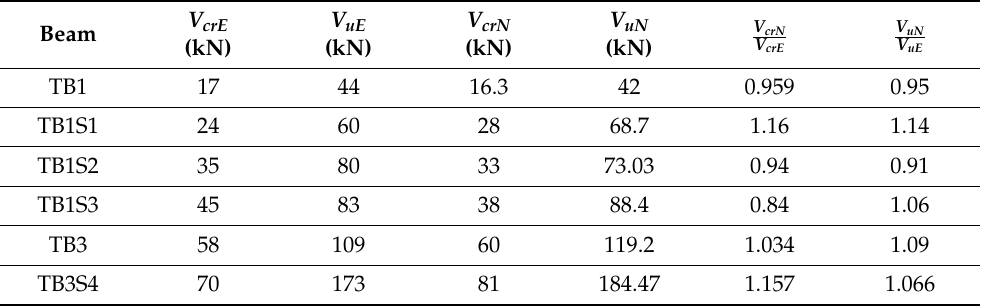
Table 6. Cracking shear, ultimate shear, and comparison of these results for beams TB1, TB1S1, TB1S2, TB1S3, TB3, and TB3S4.